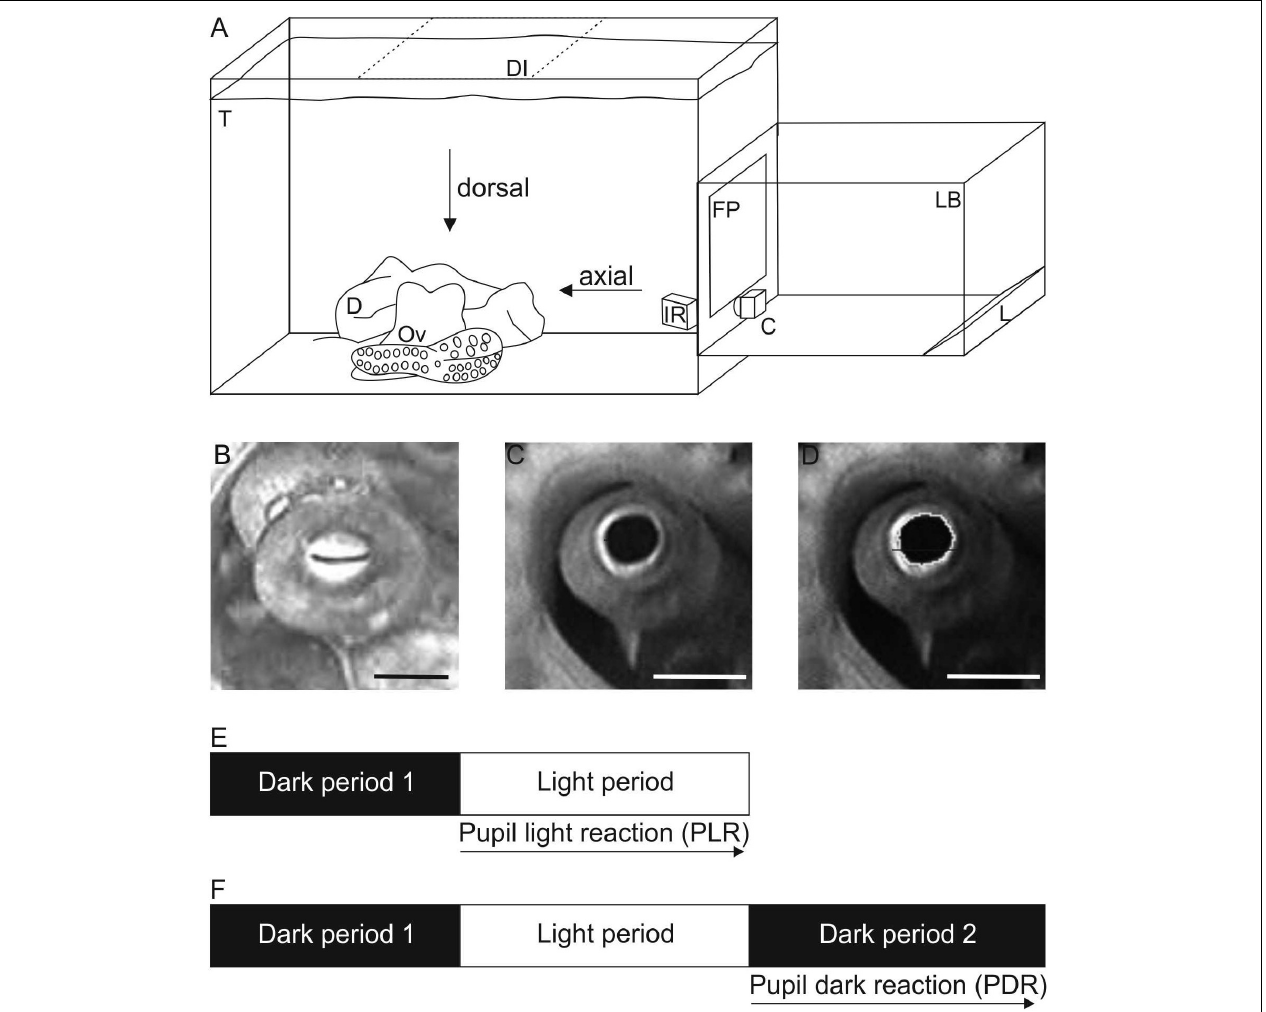
FIGURE 1 | Experimental setup and procedure. (A) Sketch of the experimental setup to record pupillary responses. During measurements, the animal (Ov) was hiding in its den (D) in its holding tank (T). The scene was either illuminated axially with the light box (LB) and camera C as shown or from dorsal (position of light box shaded, DI; camera remains in position as during axial illumination). Within the light box, light of three reflector light bulbs (L) was reflected numerous times by aluminum foil lining the inside of the box before it indirectly hit the semitransparent front plate (FP). The scene was additionally illuminated by infrared light (IR) allowing to document the pupil in darkness/dim light conditions. Not drawn to scale. (B–D) Pupil of Octopus vulgaris . B Constricted pupil when the scene was illuminated with 170.3 cd/m 2 axially. Absolute pupil area was 4 mm 2 on this frame. C Dilated pupil measured in darkness under IR-light before the light was switched on. Absolute pupil area was determined as 33 mm 2 on this frame. (D) Image of the dilated pupil showing how the pupil was encircled in ImageJ to determine the pupil area. Scale 10 mm. (E,F) Sketch of the experimental procedure to document (E) the pupil light reaction (PLR) and (F) the pupil dark reaction (PDR). For both pupil reactions, the animal was first kept in darkness (dark period 1) followed by a light period. During this light period with a specific light level set up, the pupil light reaction was documented. The pupil dark reaction was recorded in a subsequent dark period (dark period 2).